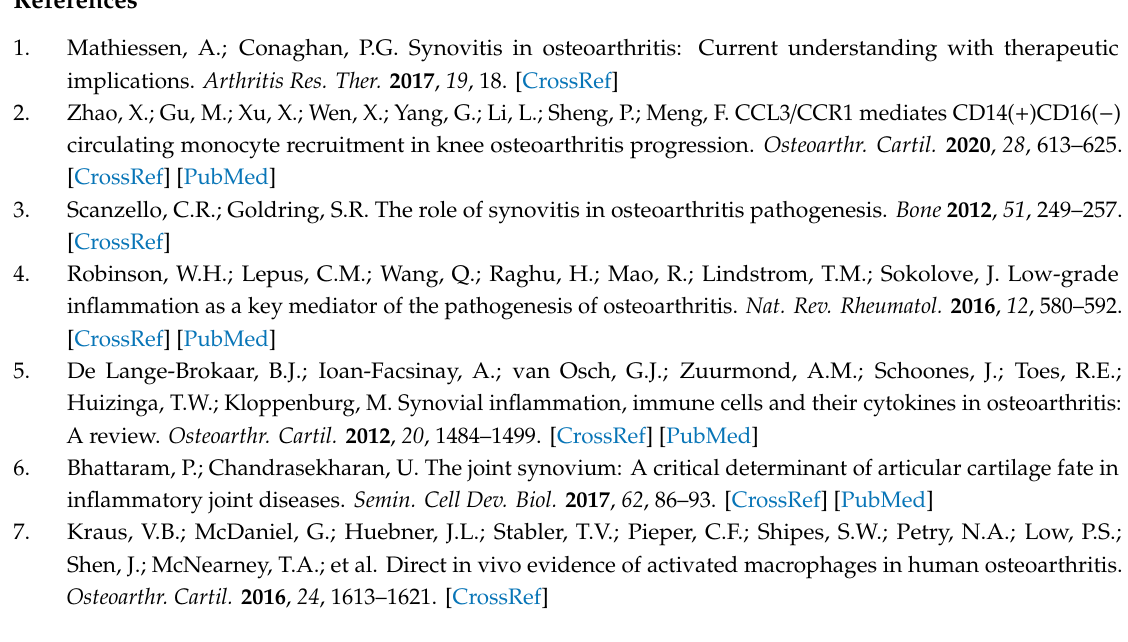
Figure S1: Flow cytometry evaluation of macrophages markers CD68, CD86 and CD206 evaluated both on CD14-positive (CD14 + ) and -negative (CD14 − ) synoviocytes ( n = 4), Table S1: Oligonucleotide primer